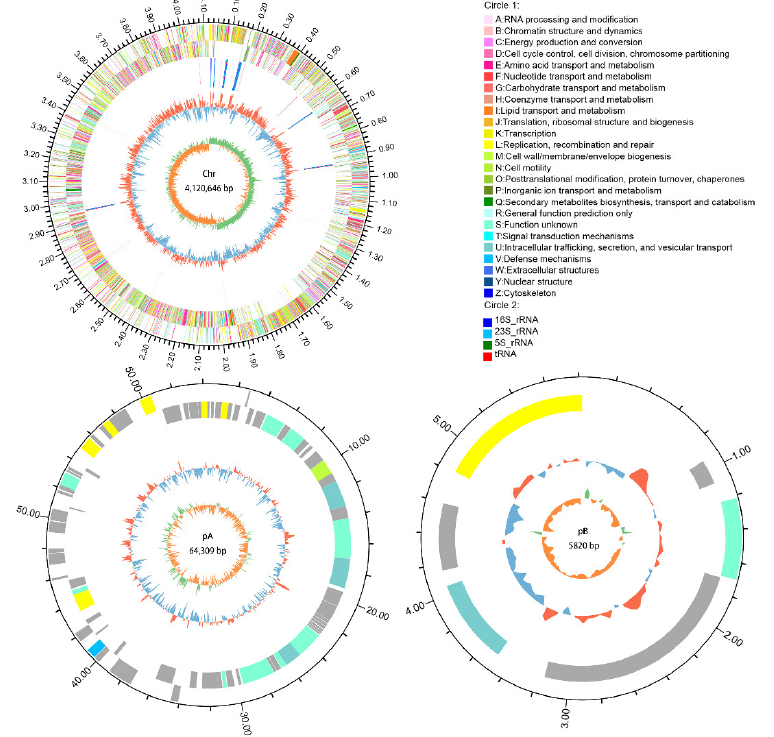
Figure 4. Genome map of B. subtilis A-5 (Chr, pA, and pB). Rings from the outside as follows: (1) scale marks, (2) CDSs information in the forward strand, (3) CDSs information in the reverse strand, (4) rRNA and tRNA genes, (5) GC content (deviation from average), (6) GC skew.